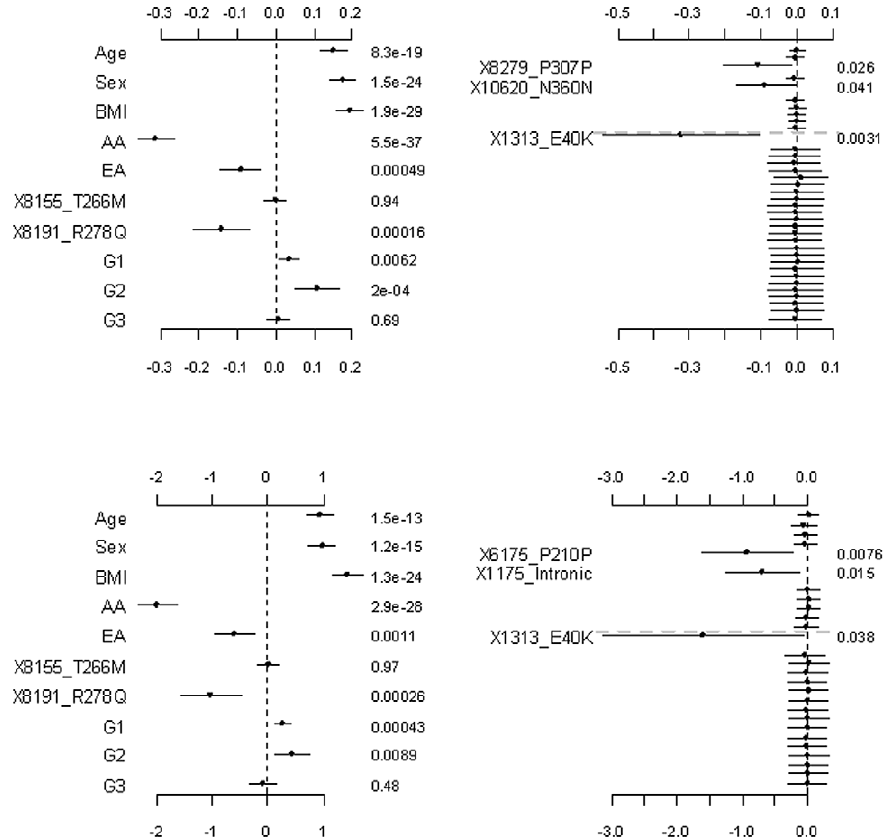
Figure 4. Analyses of the hierarchical GLMs with fixed scale s a =0.5. The top and bottom panels are for the continuous and binary traits, j respectively. The left panel is for the covariates, the two common non-synonymous variants and the three group effects (G1: common synonymous; G2: rare non-synonymous; G3: rare synonymous). The right panel is for the adjusted main effects (the gray dotted line shows the two groups G1 and G2). The points, short lines and numbers at the right side represent estimates of effects, 6 2 standard errors, and p -values, respectively. Only adjusted main effects with p -value , 0.1 are labeled.